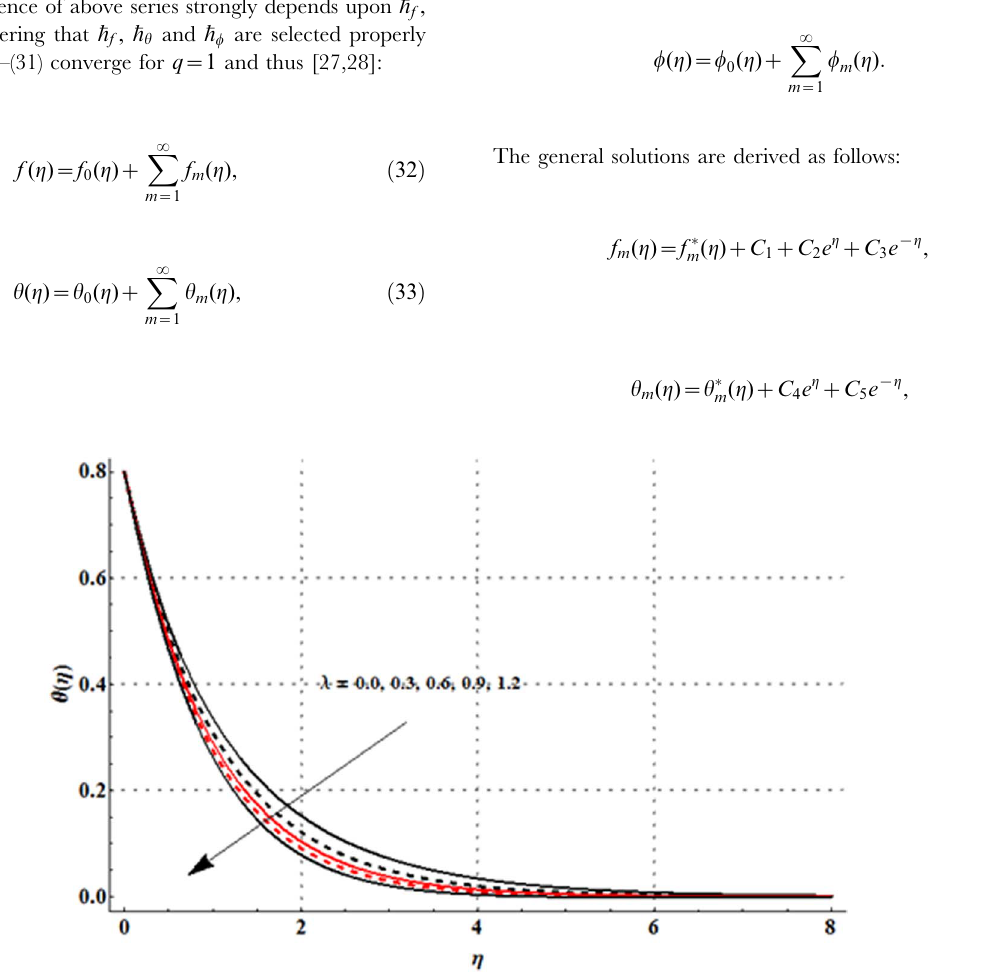
Figure 12. Influence of l on the temperature profile h ( g ) when M ~ 0 : 6, b ~ 0 : 4 ~ Rd , l 1 ~ 0 : 5, N ~ 0 : 3, Pr ~ 1 : 2, S ~ 0 : 2 ~ S (cid:2) and Sc ~ 1 : 0 :